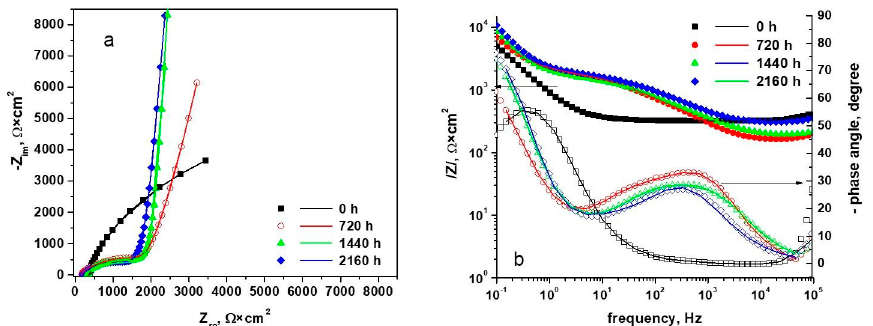
Figure 6. Nyquist ( a ) and Bode ( b ) diagrams for 310H samples after different oxidation times at 500 °C and 250 atm. Symbols show experimental data, whereas lines represent fitted data using the electrical equivalent circuit (EEC).